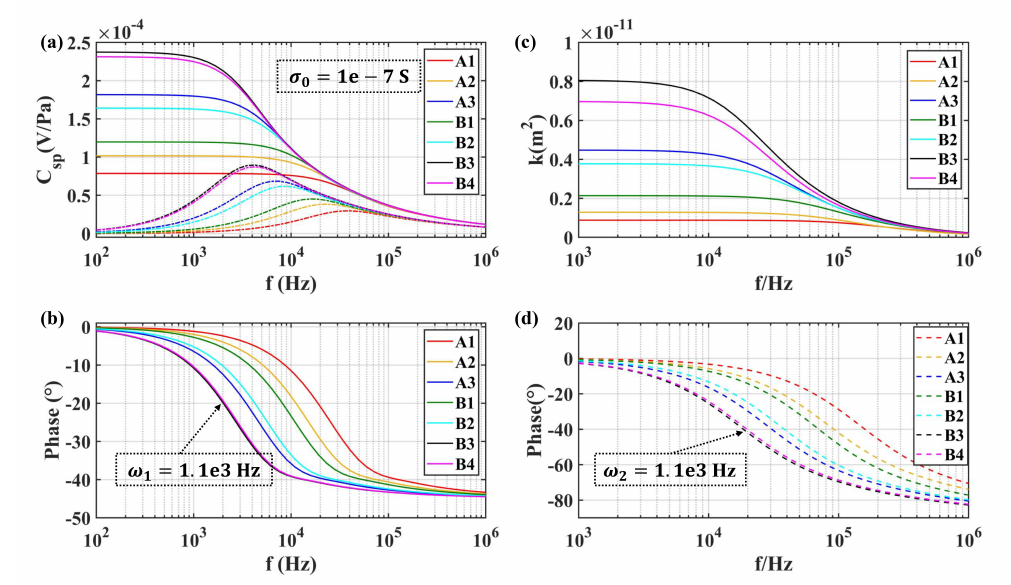
Figure 14. Frequency-dependence of SPC and permeability for different types of transducers at σ 0 = 1 × 10 − 7 S: ( a ) the amplitude of C sp ; ( b ) the phase of C sp ; ( c ) the amplitude of permeability; ( d ) the phase of